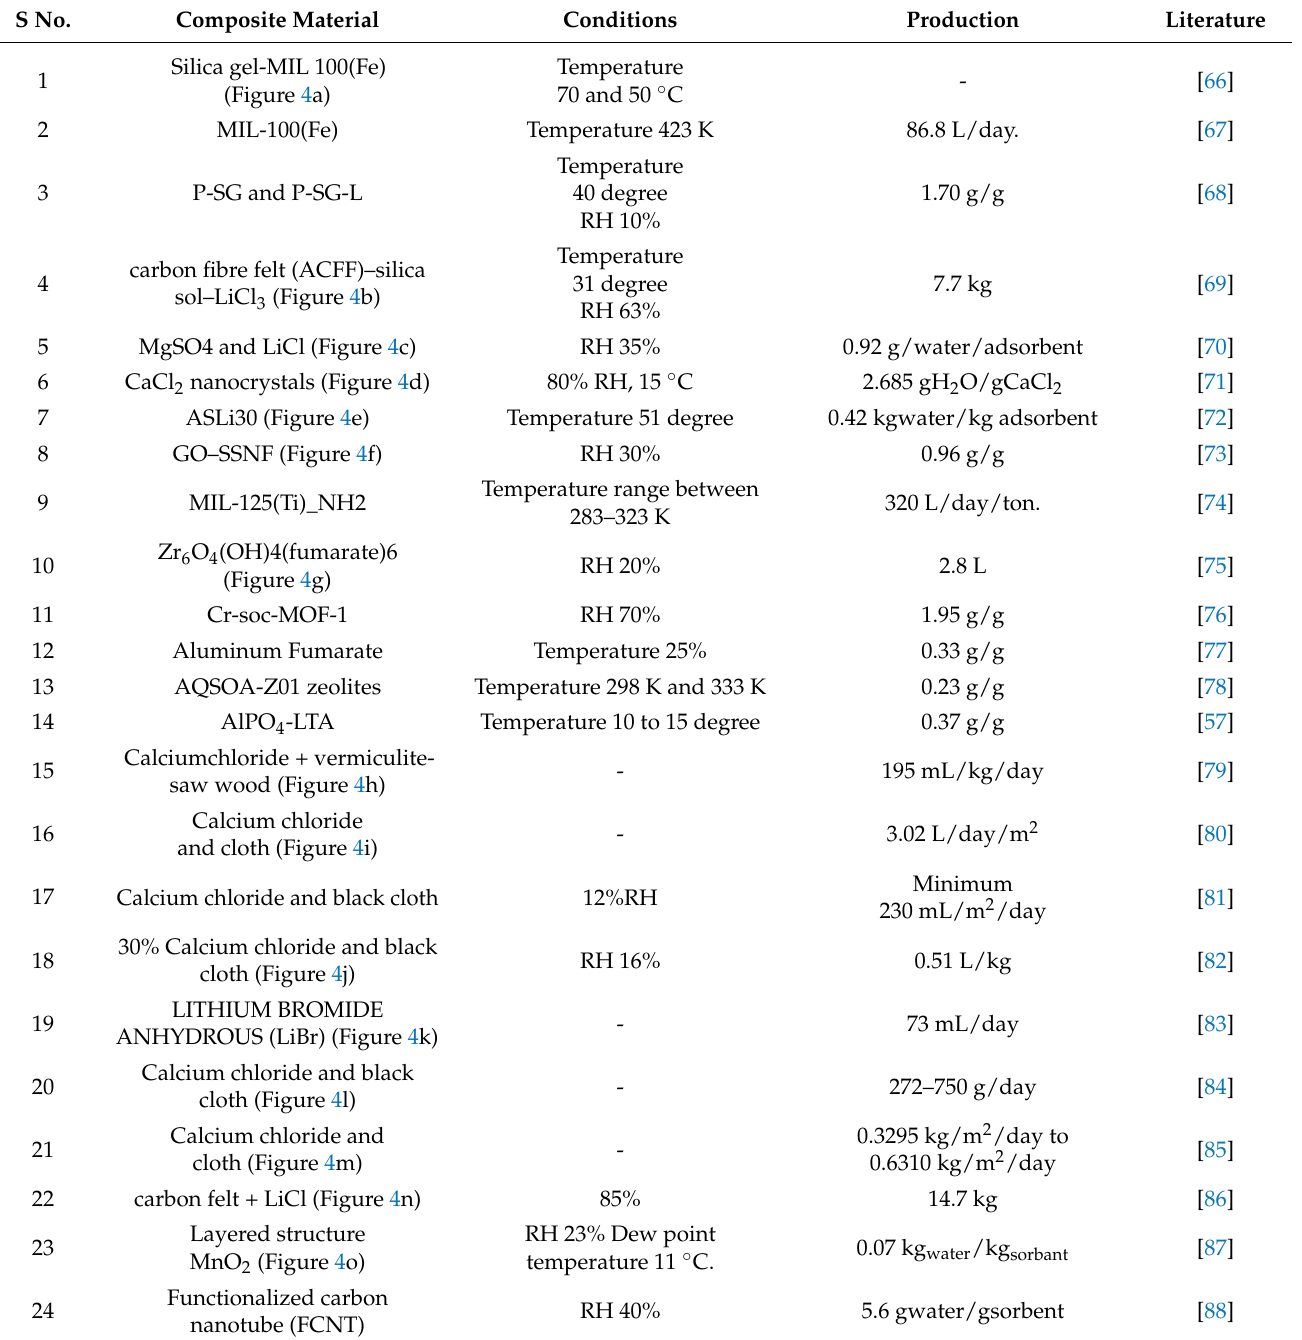
Table 3. Comparison of different types of sorption-based atmospheric water